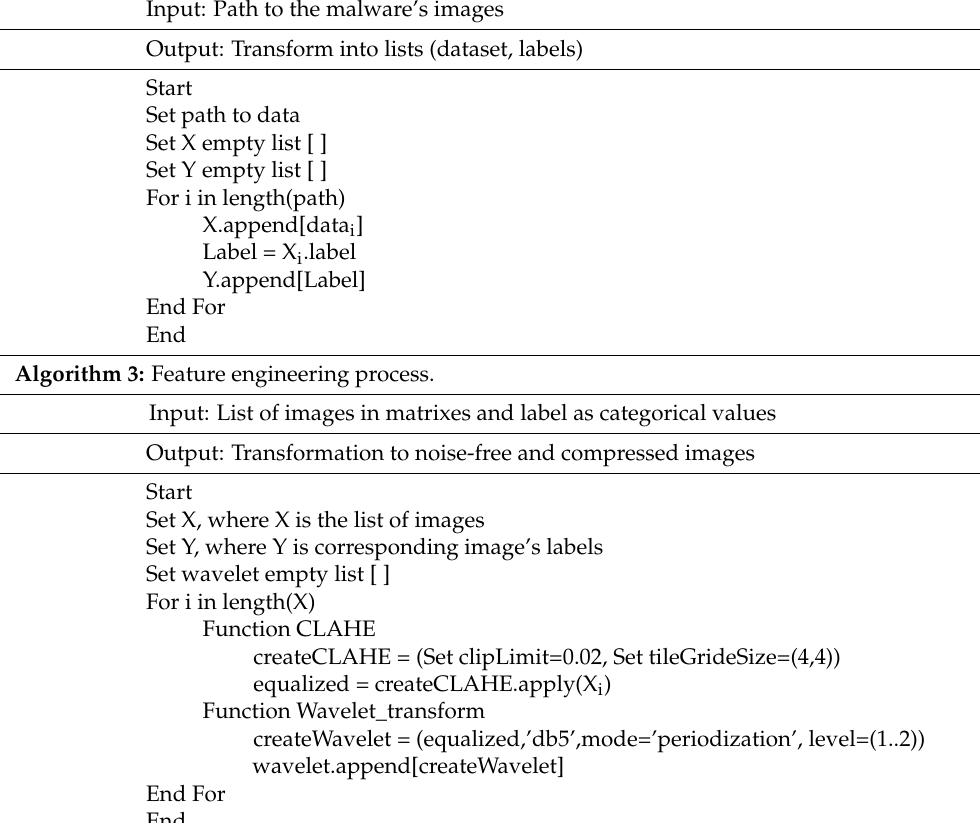
Table 4. Pseudocode of the algorithm used to denoise and compress the malware’s images. Algorithm 2: The algorithm to convert images to list.